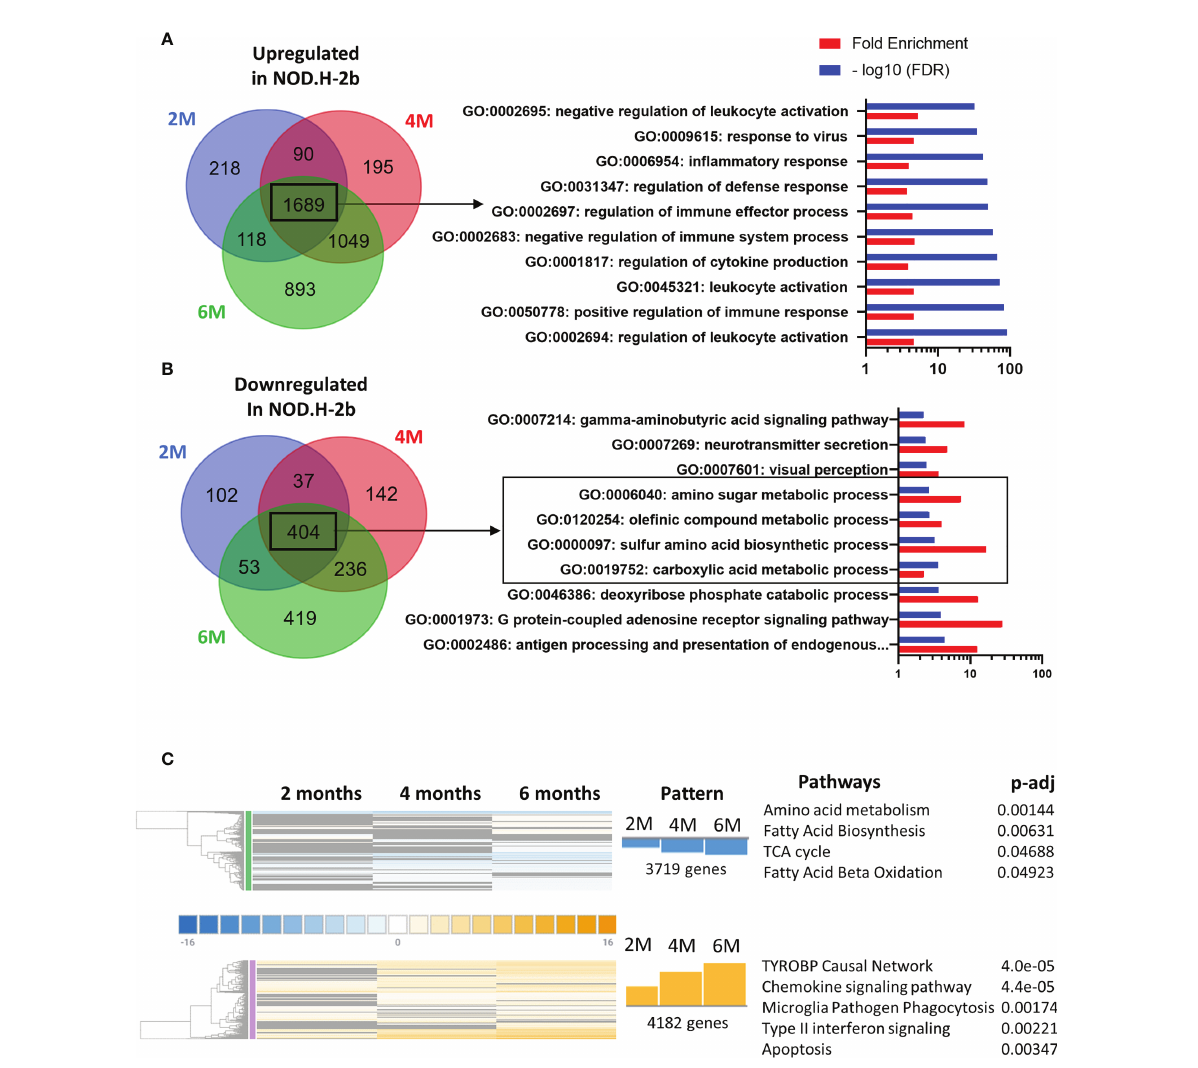
FIGURE 3 Pathways enriched in DEGs in NOD mice compared to BALB/c at the different ages. Identi fi cation of pathways enriched in DEGs common at each stage on the Venn diagram. Common DEGs upregulated (A) in NOD.H-B2 mice are exclusively involved in immune system whereas DEGs downregulated (B) common at each age are relative to the metabolism. (C) Meta-analysis of DEGs revealed two different patterns. In blue, 3719 genes present a pattern with a more important downregulation with age are associated with metabolism. In Orange, 4182 genes present a similar pattern with an increase of their expression from 2 to 6 months. These genes are involved in different type of immune response and apoptosis.